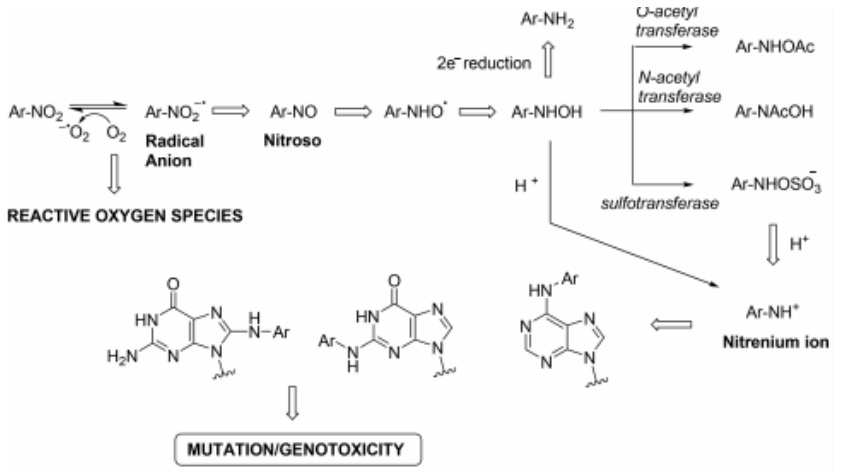
Figure 2. Mutagenic pathway of nitroarenes